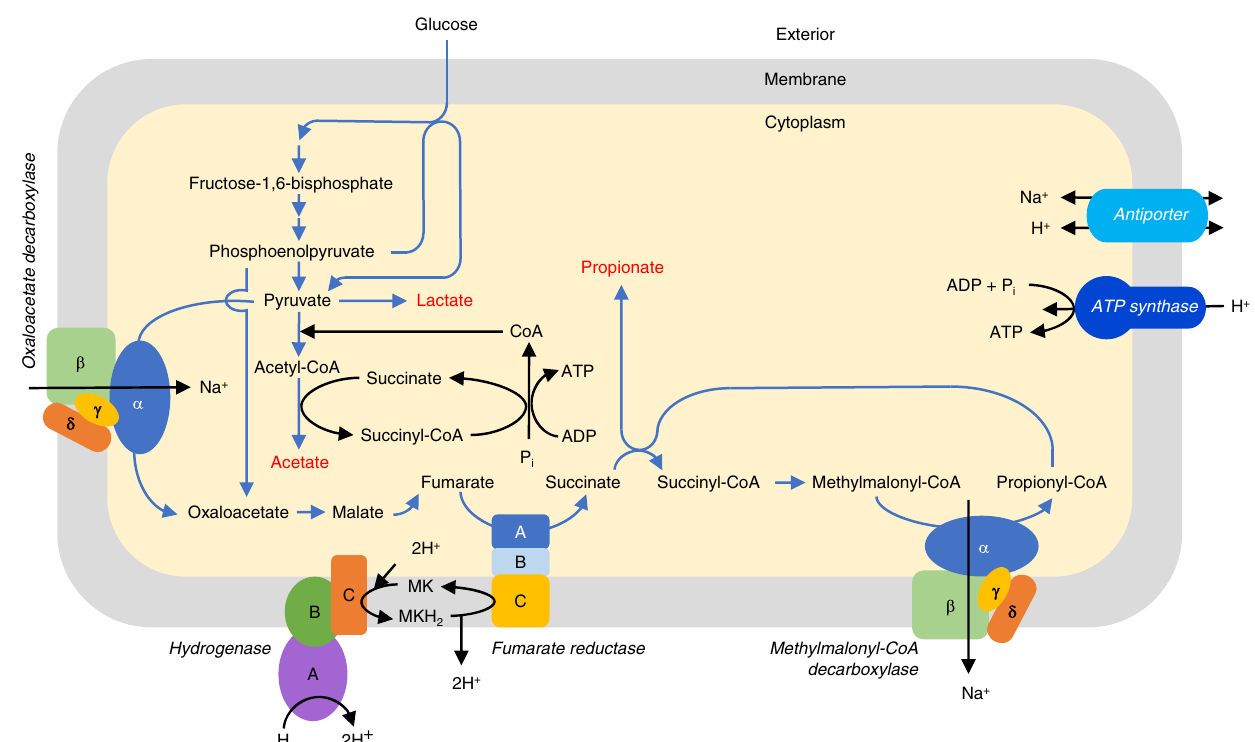
Fig. 6 | Schematic showing the glucose fermentation pathway of Quinella . The construction isbased on thefour Quinella genomic bins and analyses presented in this paper. The proposed end products are shown in red font, carbon fl ow is indicated by blue arrows, other transfers by black arrows, and some enzymes are labelledinitalicfont.Thesubunitsandfunctionsoftheoxaloacetatedecarboxylase